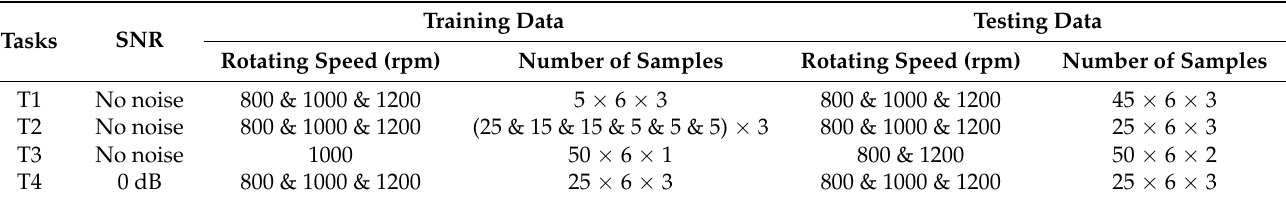
Table 3. Dataset information of four fault diagnosis